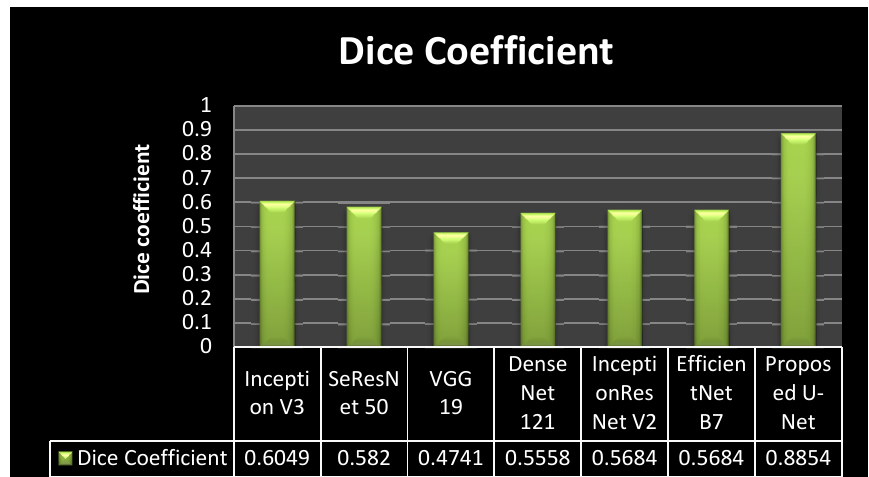
Figure 11. Dice Coefficient Comparison Graph.